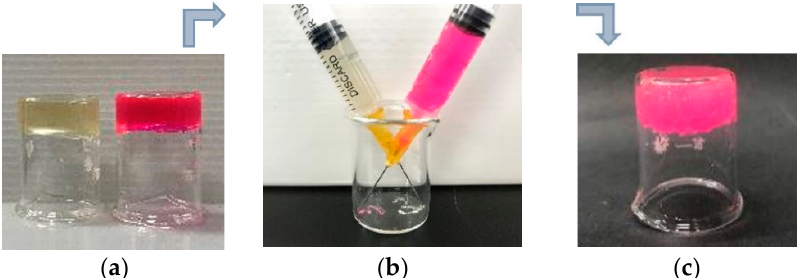
Figure 4. Digital photos of injectable CMC-OSA-DTP hydrogels before and after injecting. ( a ) The preparation of two different hydrogels. The red hydrogel was stained with rhodamine B for visual discrimination; ( b ) hydrogels passed through needles and injected in the same beaker. ( c ) The integral hydrogel formed after self-healing.